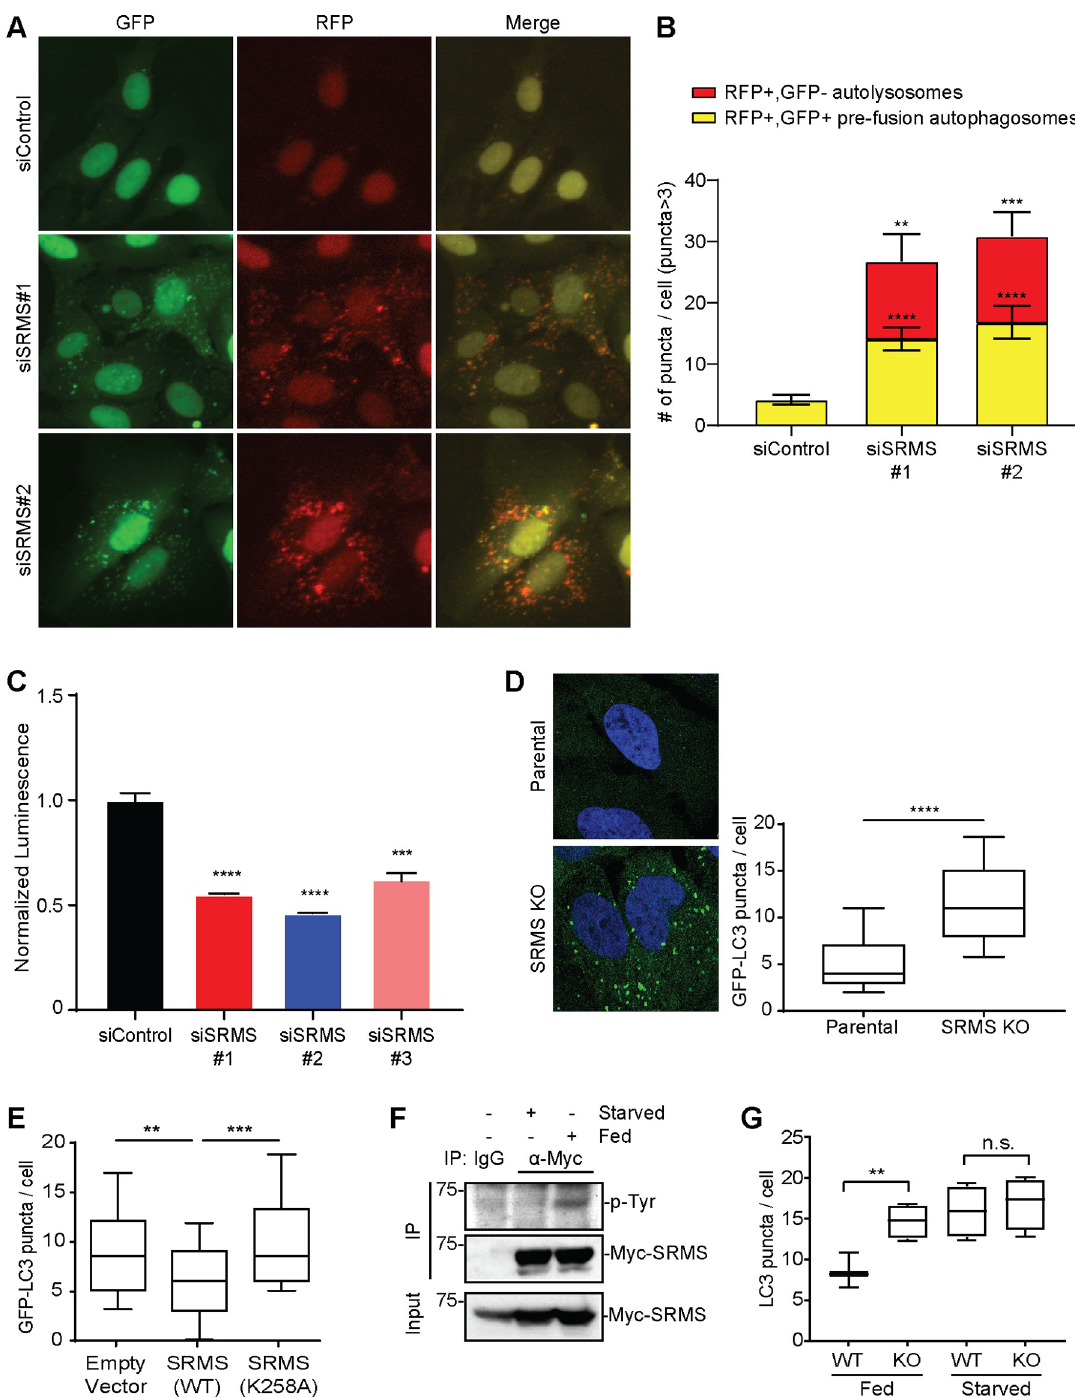
Fig 1. SRMS restrains autophagy under nutrient-replete condition. ( A, B ) Autophagosome–lysosome fusion was assessed in U2OS cells stably expressing tandem monomeric RFP-GFP-LC3. Seventy-two hours after transfection with the indicated siRNA oligonucleotides cells were imaged by IncuCyte to identify prefusion autophagic compartments (i.e., RFP+, GFP+ puncta) and postfusion autolysosomes (i.e., RFP+, GFP − puncta). Representative images are shown in ( A ) and quantitation from cells having more than 3 puncta is shown in ( B ). Mean + SEM from n = 18 cells per condition is shown. �� p < 0.01, ��� p < 0.001, ���� p < 0.0001, t test. ( C ) Autophagic flux was assessed using the Autophagy LC3 HiBiT Reporter Assay System 72 hours after transfection with the indicated siRNA oligonucleotides. Degradation of the autophagy substrate HiBiT-LC3 was detected as reduced luminescence indicative of increased autophagic flux in SRMS-depleted cells compared to controls. Mean + SEM of n = 3 triplicates is shown. ��� p < 0.001,